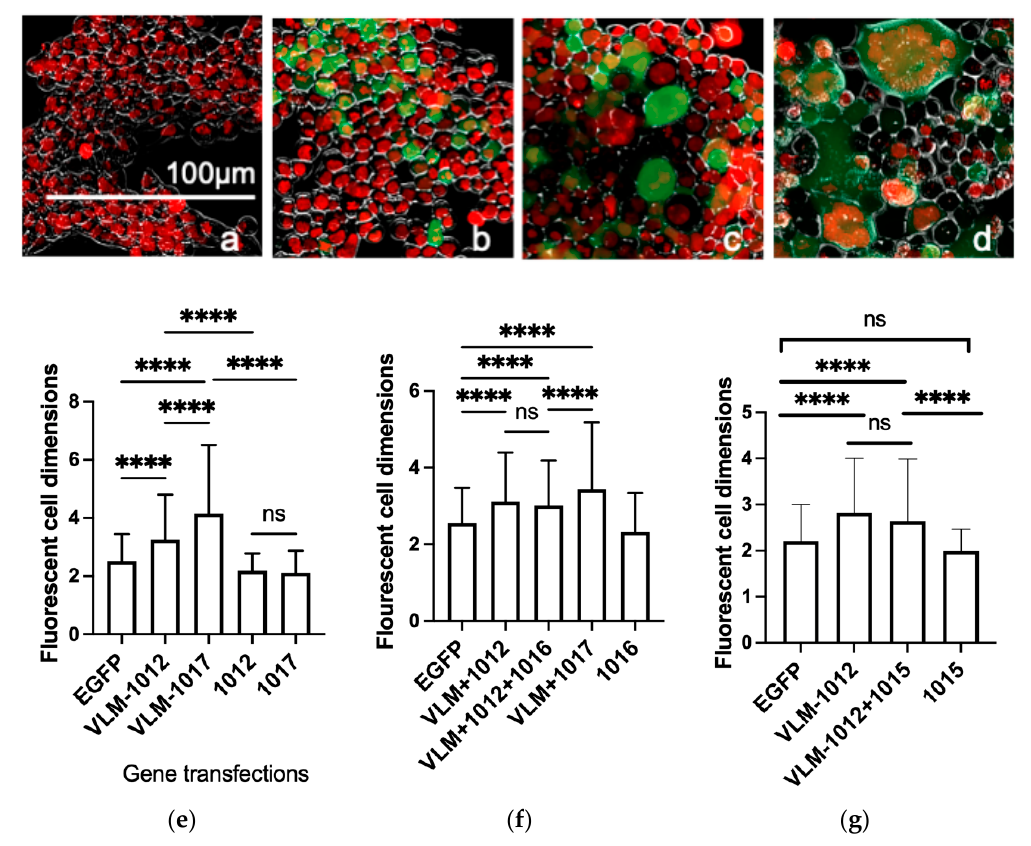
Figure 1. Cell fusion with VLM and VIT gene expression in human cells. VLM gene formulations were examined for effects on HEK 293 cell fusion by transfecting genes together with EGFP genes individually or in combined formulations as viewed for FITC filter fluorescence to show EGFP transfected gene expression, assayed 48–72 h post transfection shown in comparisons to Hoechst live stained nuclei viewed in UVA filter (coloured red to contrast green EGFP), image overlays with brightfield view ( a – d ). ( a ) HEK293 cells transfected PBS, ( b – d ) with DNA, ( b ) EGFP, ( c ) with EGFP plus VLM of gD (plasmid 1011), gBmut1 (1012), gH (1013), gL (1014), ( d ) with EGFP plus VLM of gD (1011), gBmut2 (1017), gH (1013), gL (1014). ( e – g ) The relative cell dimensions where 2 = 10